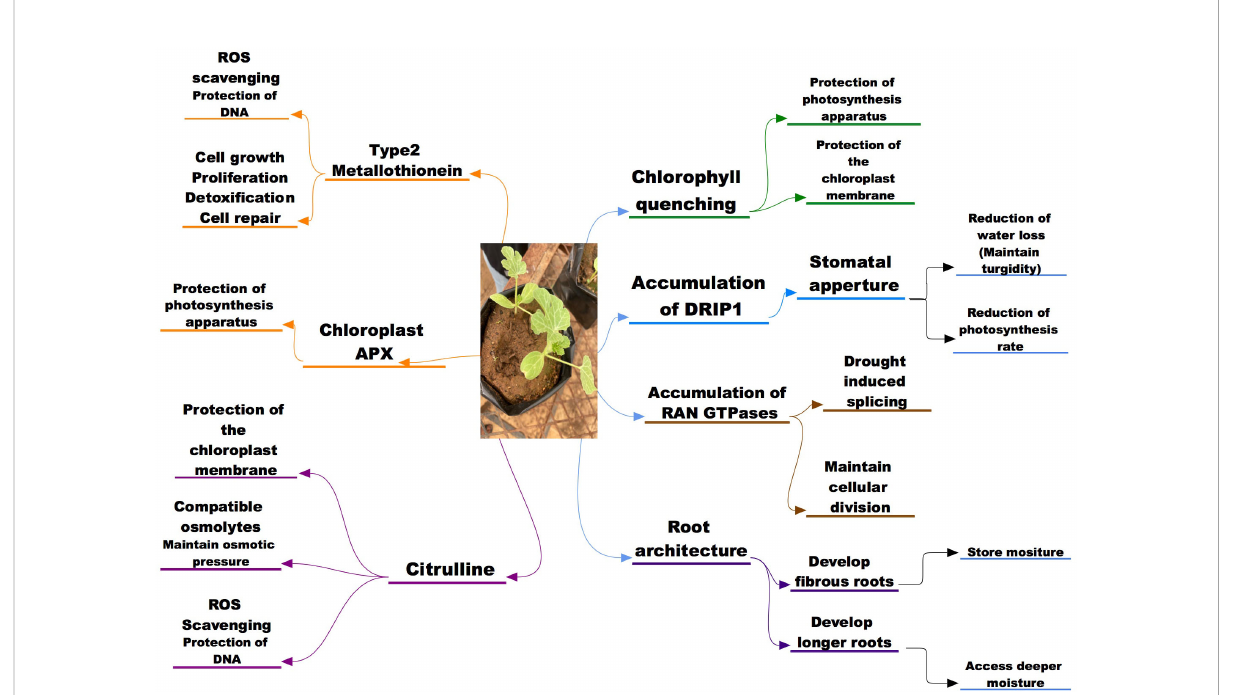
FIGURE 1 A schematic representation of the morphological, physiological and molecular potential indicators to drought and salinity stress tolerance in wild